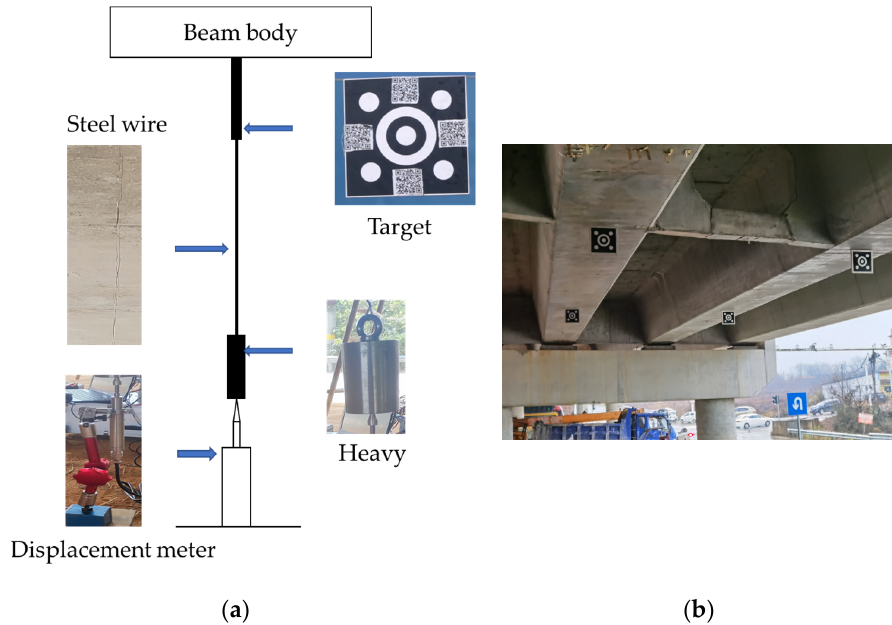
Figure 11. Site conditions of real bridge experiment: ( a ) site layout of the bridge test: ( b ) site target layout.